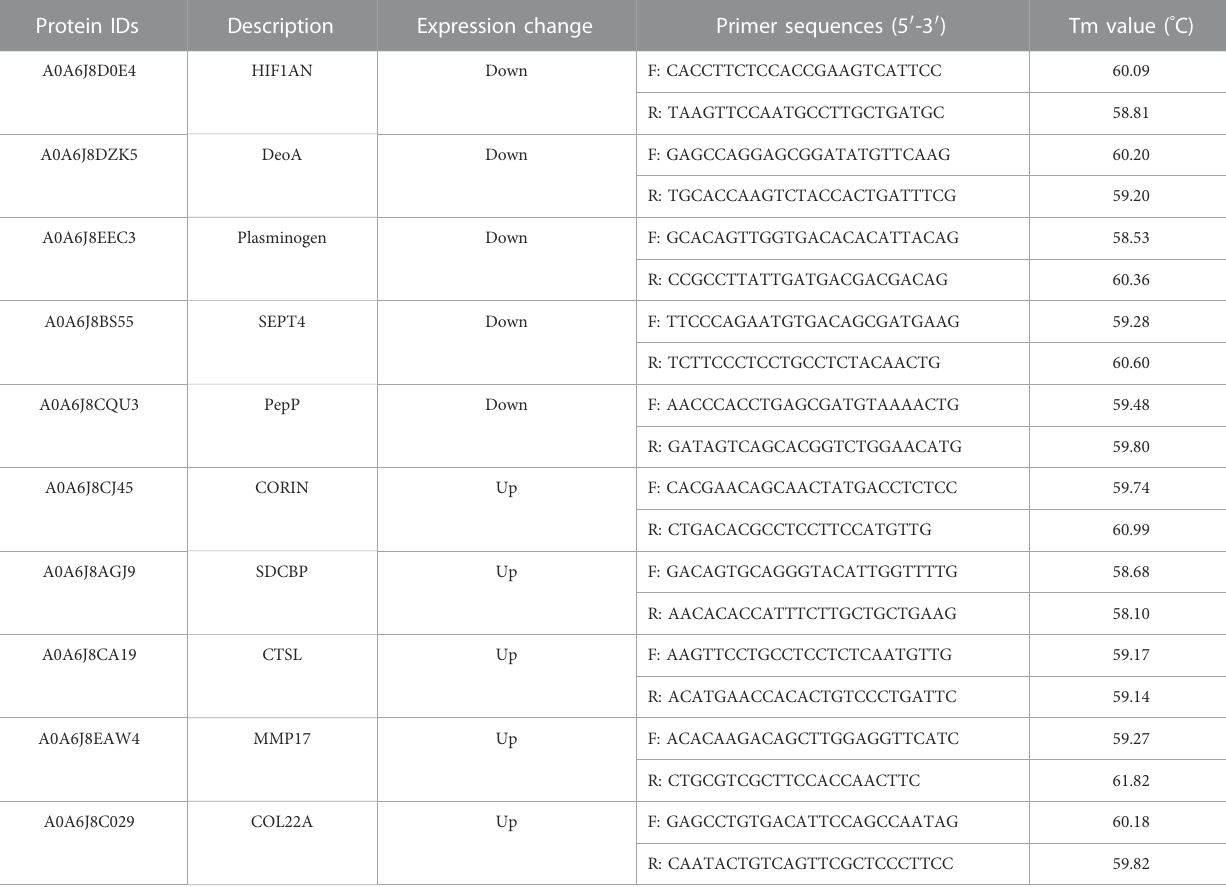
TABLE 1 Differentially expressed proteins and primer sequences used in RT-qPCR. Protein